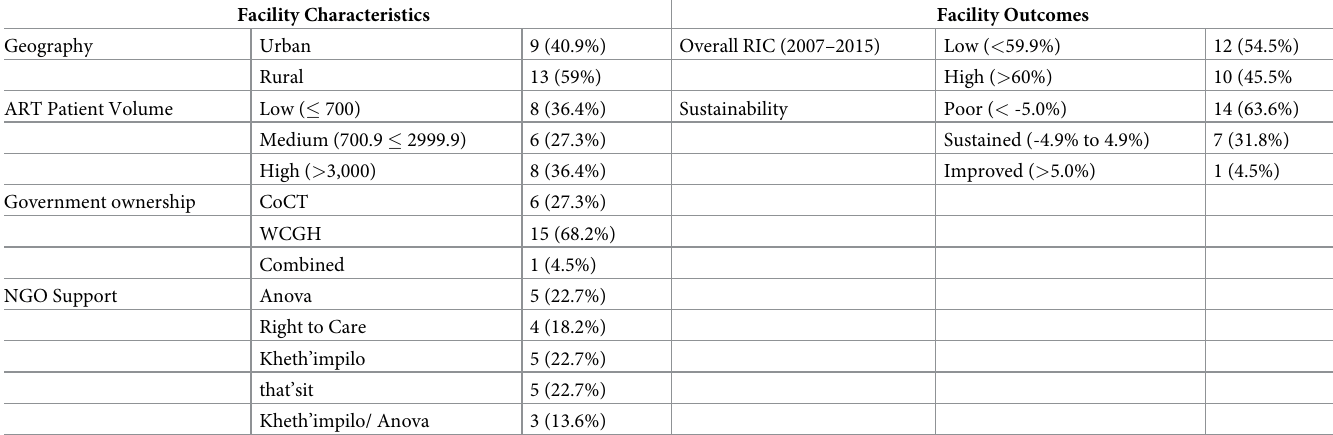
Table 1. Summary of qualitative sample by health facility characteristics and